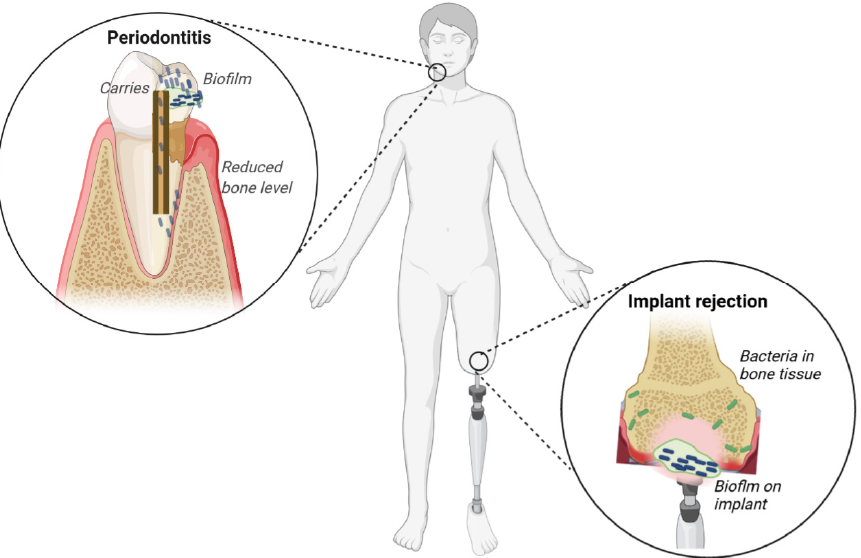
Figure 2. Schematic representation of some clinically important biofilms. Periodontitis and carrier are examples of dental infections resulting from a change in the homeostasis between the host and mouth microbiome, leading to the proliferation of pathogenic bacteria. Implant rejection is a highly undesired endpoint of a bacterial infection from either exogenous or host ‐ associated bacteria.